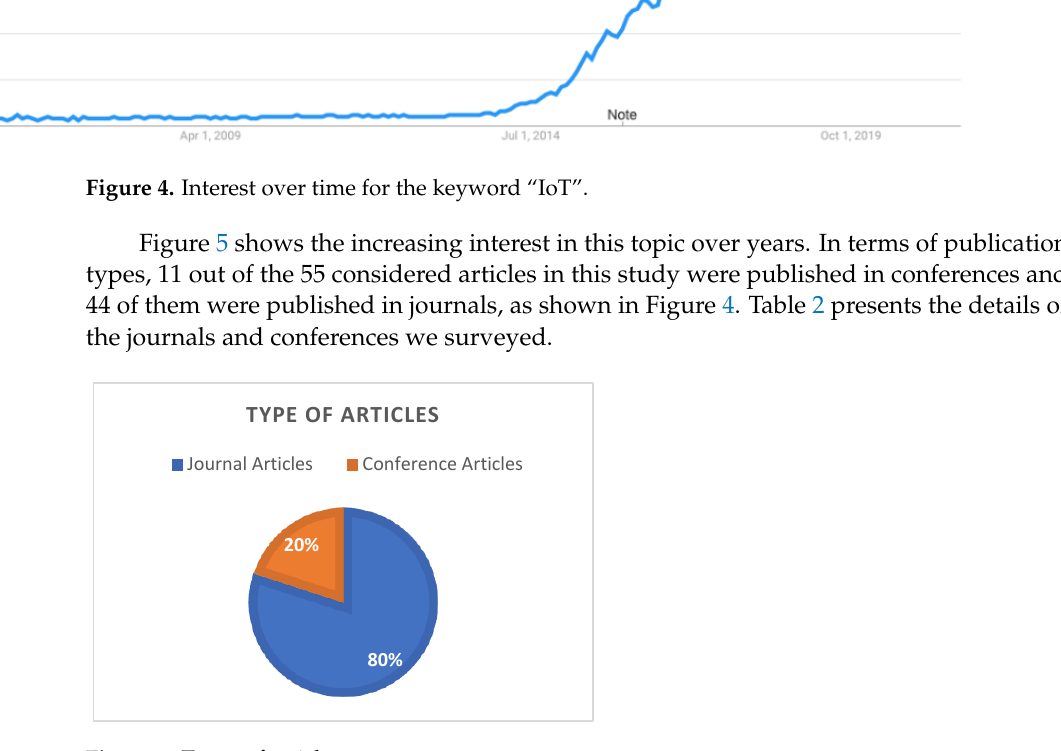
Figure 5. Types of articles. Table 2. Journal and conference distribution.